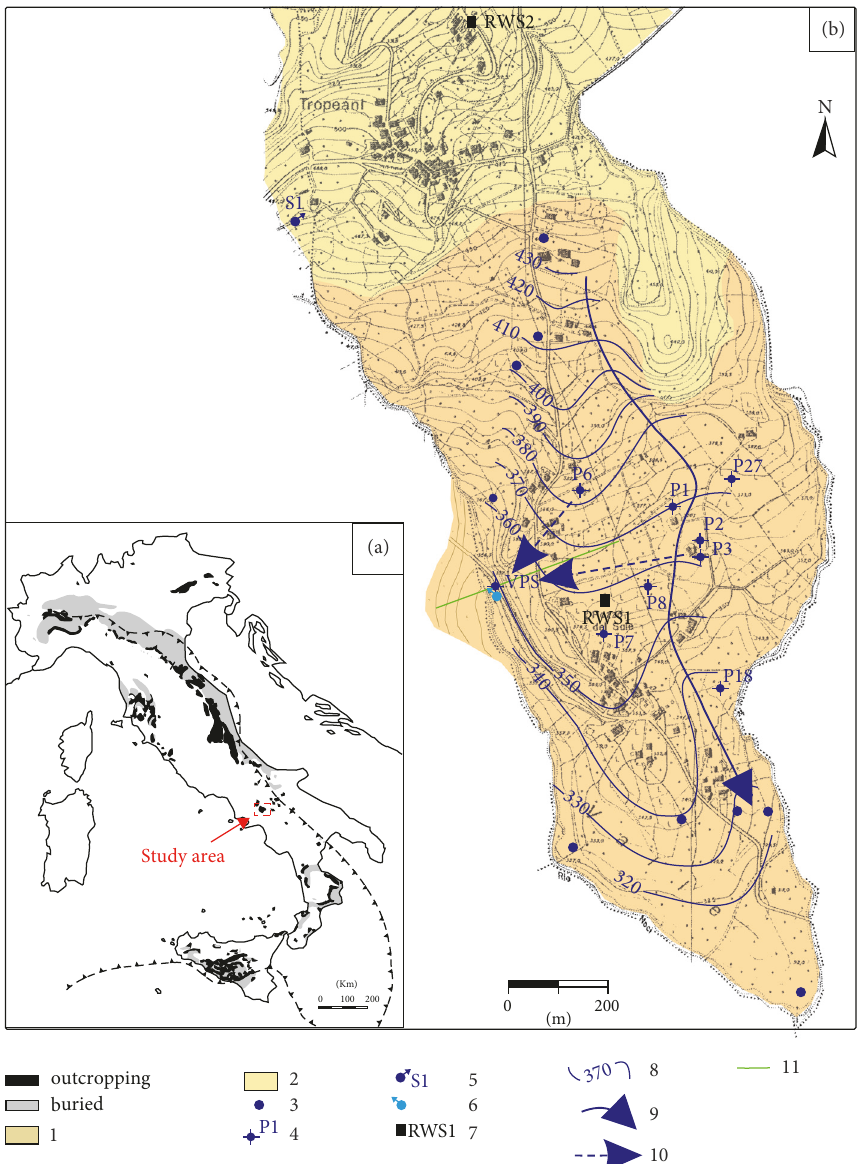
Figure 1: (a) Areal distribution of Messinian deposits (black: outcrops; grey: buried deposits) in Italy and location of the study area. (b) Hydrogeological map of the study area (piezometric contour lines related to February 2007). Legend: 1: pyroclastic deposits; 2: Messinian deposits; 3: borehole used to reconstruct the groundwater flow net; 4: monitoring borehole; 5: spring; 6: former Pozzo del Sale spring; 7: rainwater sampler; 8: potentiometric contour line related to the shallower groundwater (upper subsystem) (masl); 9: main groundwater flow direction in the upper subsystem; 10: groundwater flow direction in the lower subsystem; 11: geophysical section.